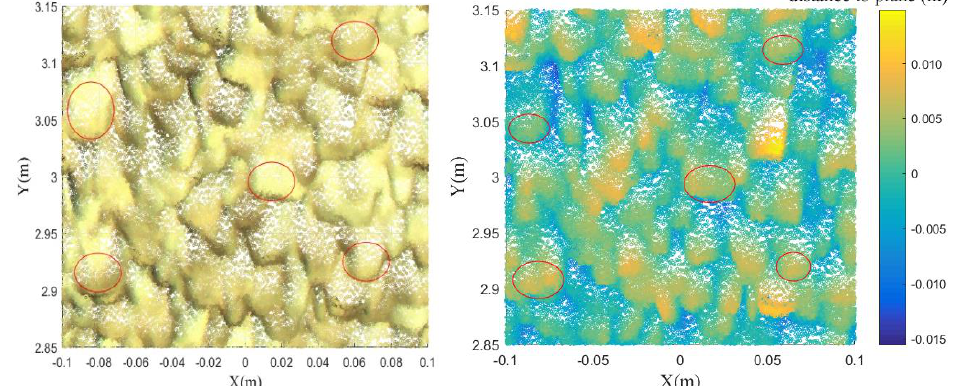
Figure 11. Raw data of the stones, left colored by RGB and right colored by the distance to the slope plane. `Negative` distances up to 15 cm represent points below the slope plane; positive distances come from points above the slope plane: several single stones are